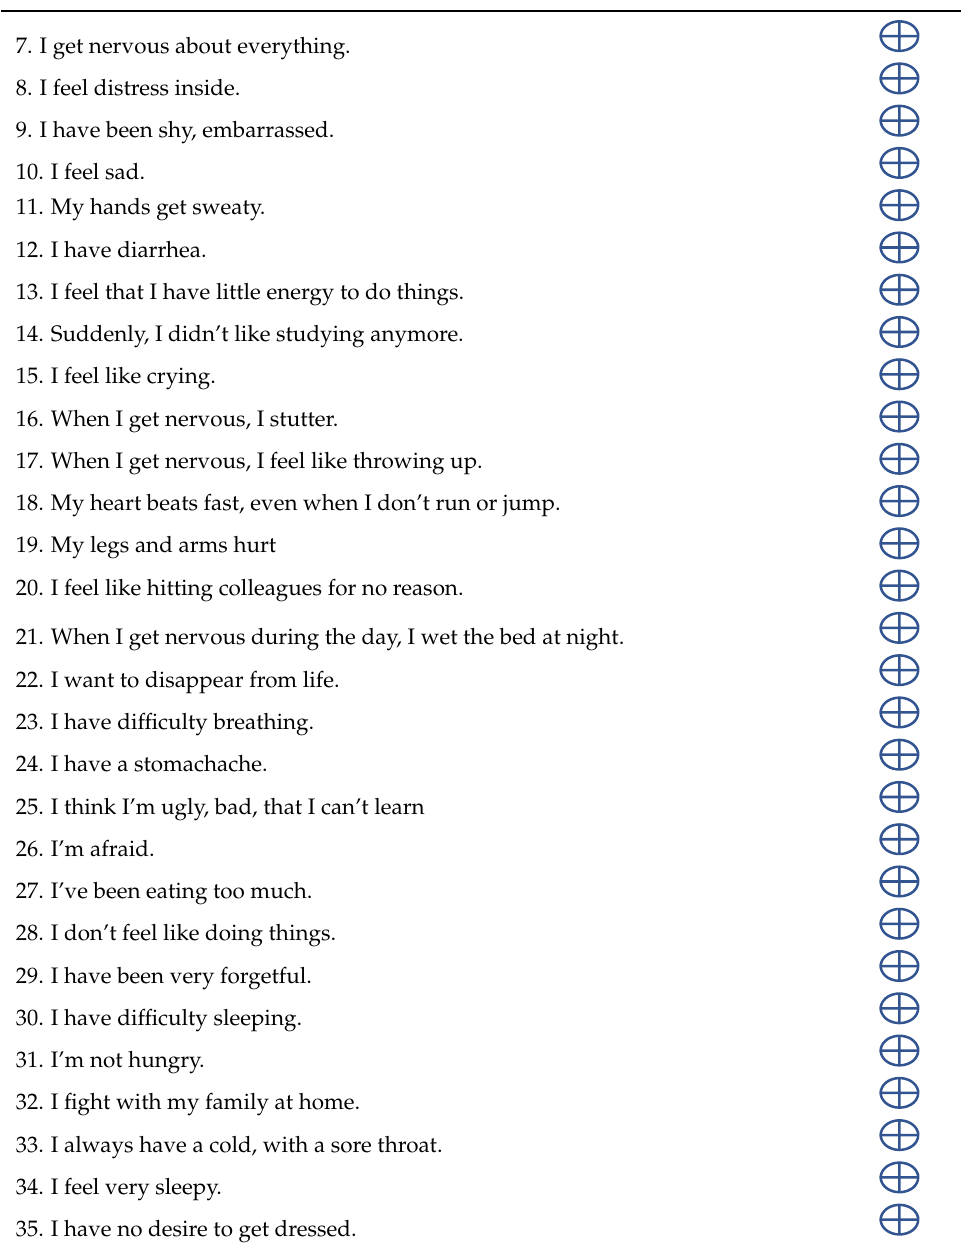
Table A2. Data collection instrument for the Infantile Stress